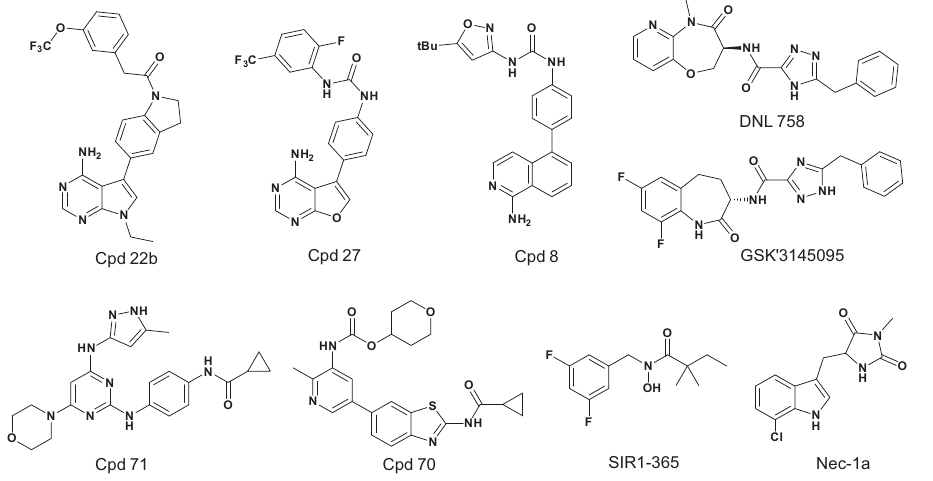
Fig. 1 | Chemical structures of representative RIPK1 inhibitors with different